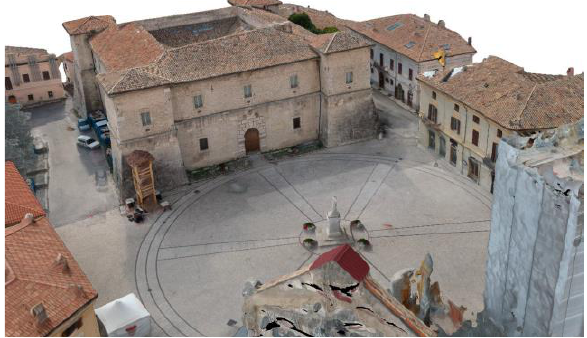
Figure 1. A detailed and accurate 3D mesh model derived from UAV cloud of the San Benedetto square (Avena, 2020).